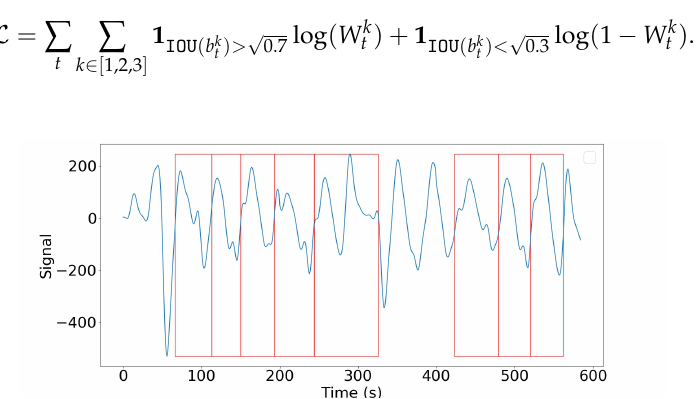
Figure 7. Example of the boxes’ delimiting steps in a walk signal. Only parts of the signal that can be undoubtedly connected to a step are